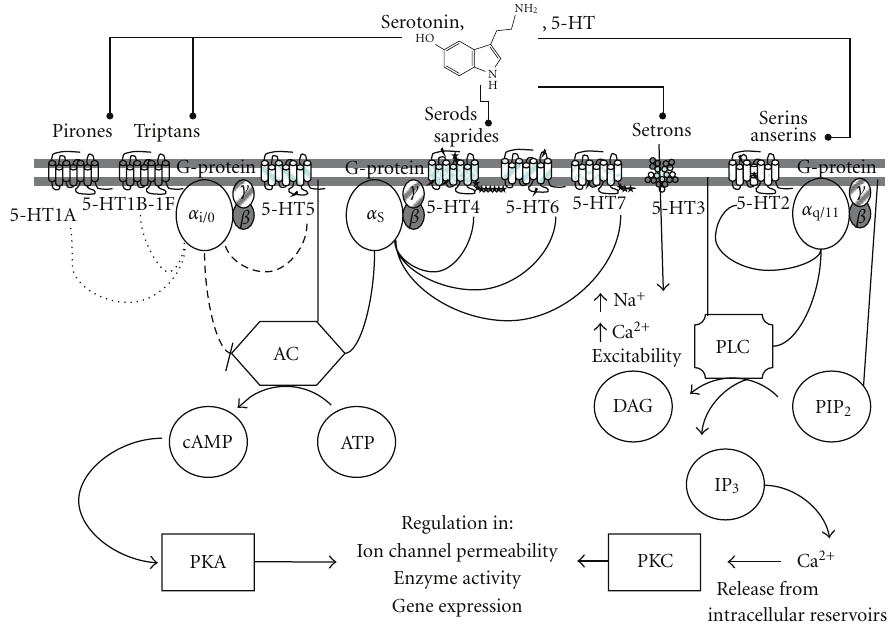
Figure 3: Serotonin main signaling pathways. 5-HT or agonists/antagonists for each receptor ( • ) interact in the extracellular side and the conformational changes of 5-HTRs modify the activity of specific intracellular enzymes, which in time modify other targets state to provoke di ff erent cellular responses [43]. G-protein βγ pathways are not represented in the figure. All of the serotonin receptor subtypes are represented for a hippocampal pyramidal cell, as reported, but subpopulations of these neurons might di ff erentially express 5-HT receptors. AC, adenylate cyclase; PLC, phospholipase C. The 7TMD images of each subtype receptor are represented with the defined number of exons that code for the mature protein [44]; putative intron location in correspondent pre-mRNA is marked by a lightning symbol ( (cid:2) ), and alternative splicing sites are marked with stars ( (cid:2) (cid:2) (cid:2) ).